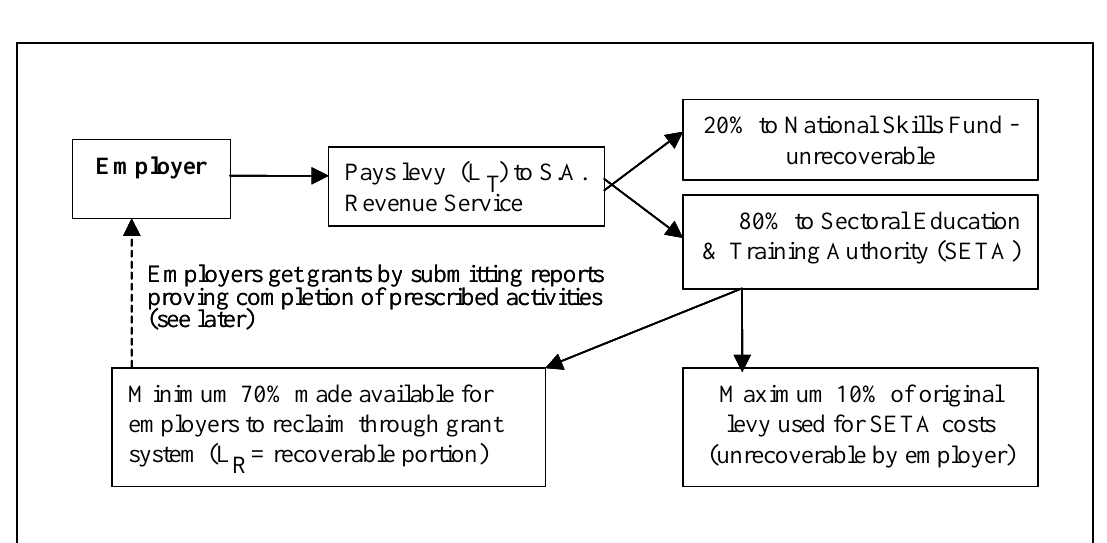
Figure 1 Schematic representation of South African skills levy system